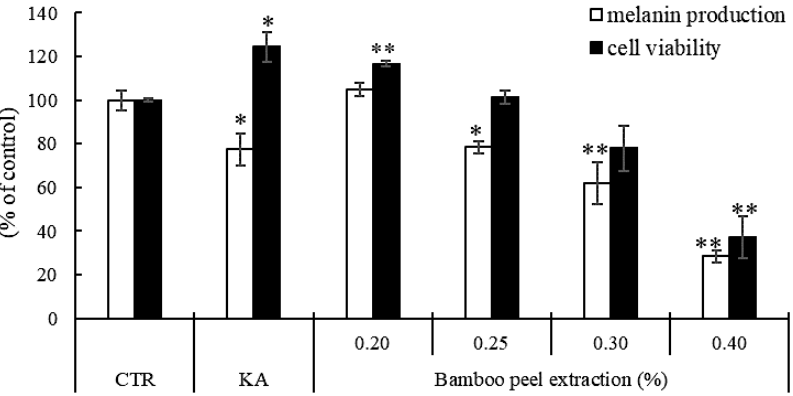
Figure 1. Inhibitory effects of different concentrations of bamboo peel extract on melanin synthesis in B16 melanoma cells (* p < 0.05 and ** p < 0.01).